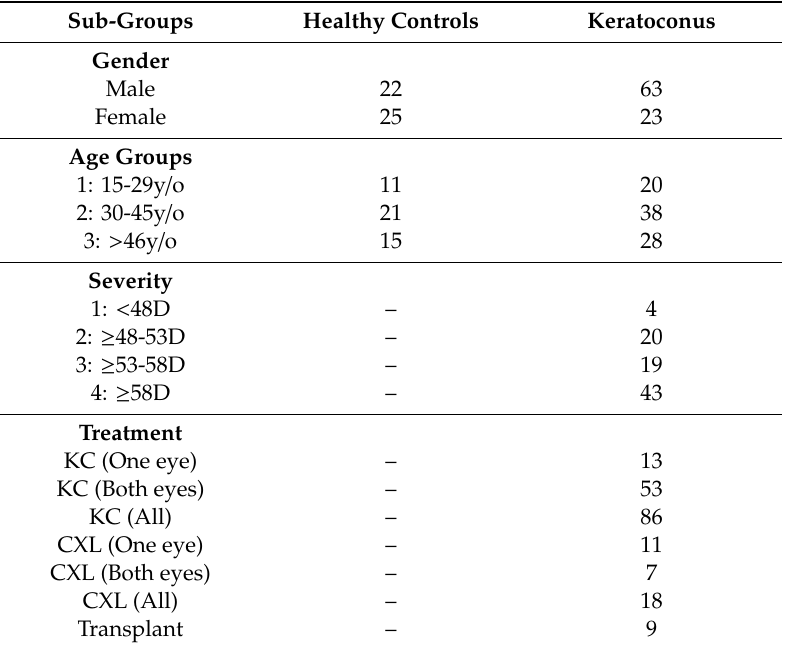
Table 1. Demographic characteristics of the Keratoconus and the healthy control